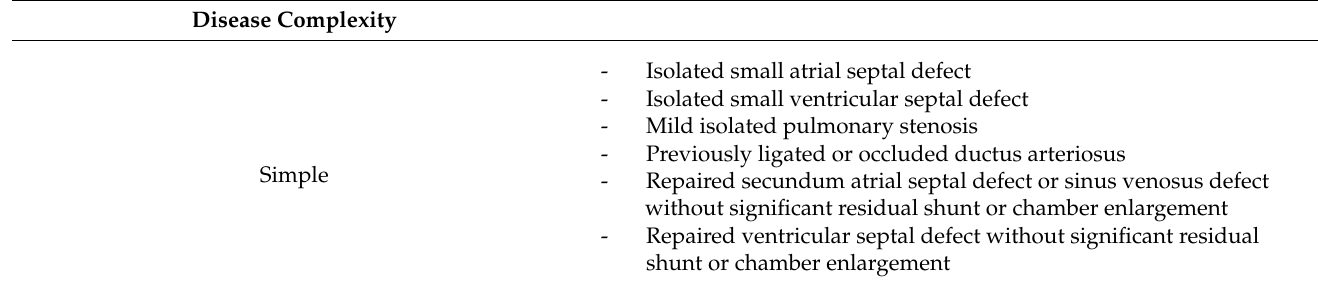
Table 1. CHD classifications on the basis of complexity.